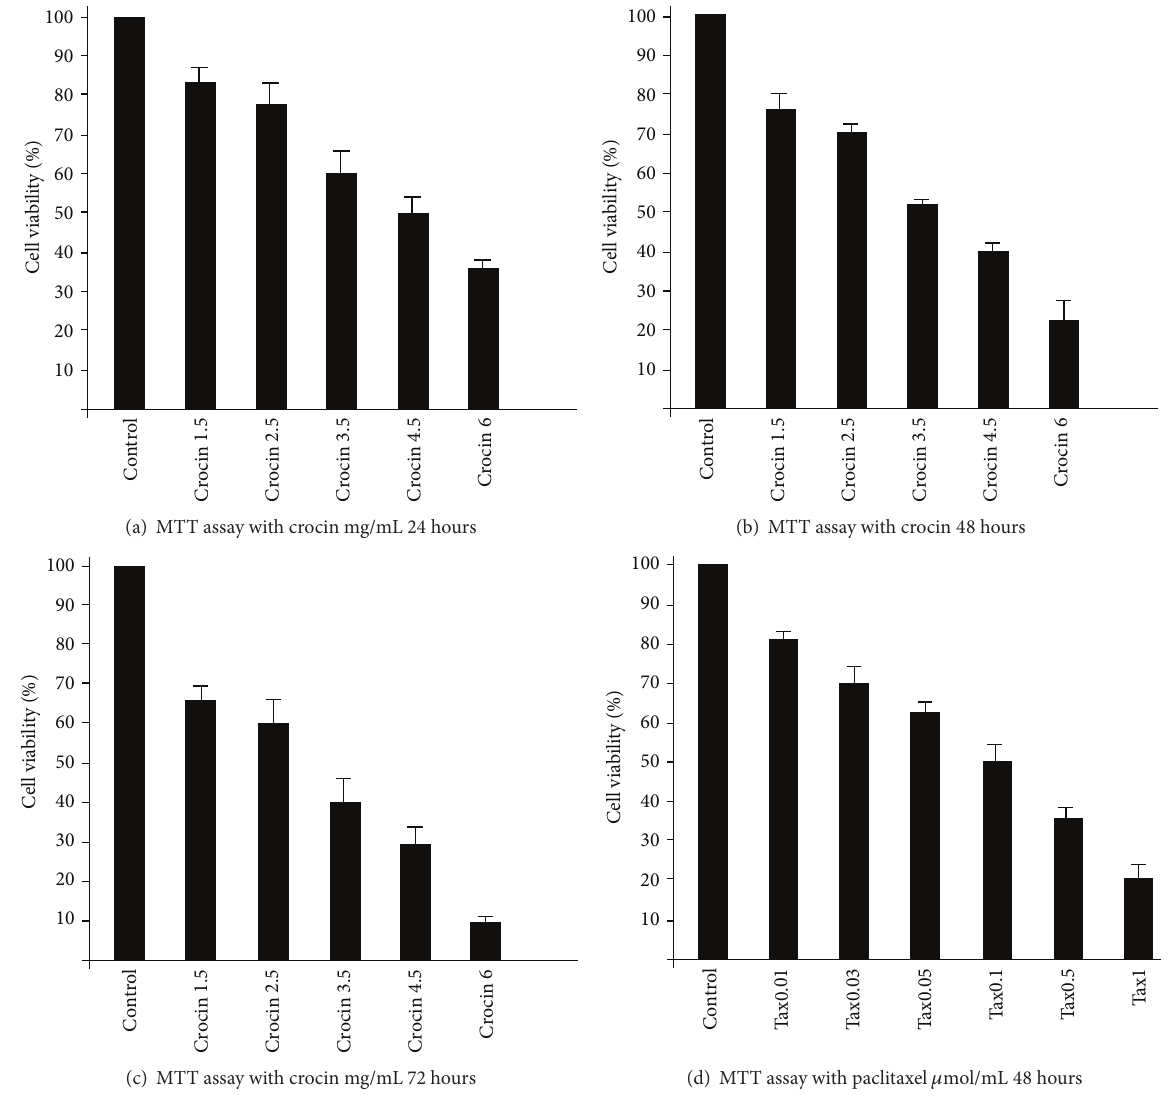
Figure 1: Survival rate of Mcf-7 cells with different concentration of crocin in (a) 24 h, (b) 48 h, and (c) 72 h. (d) The survival rate of Mcf-7 cells with different concentration of paclitaxel in 48 h measured by